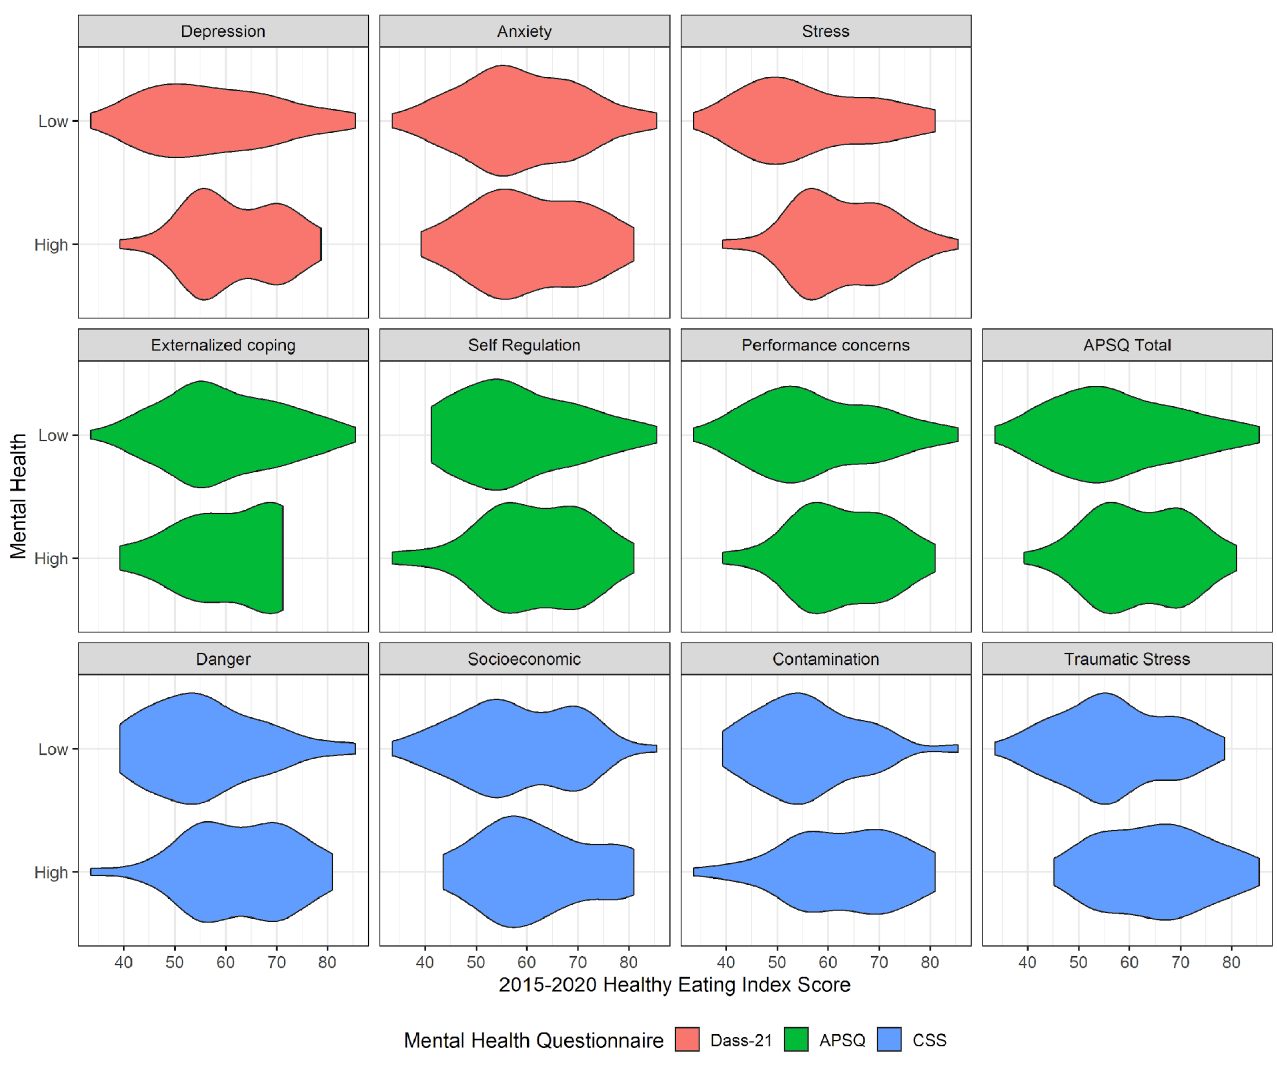
Figure 3. Visual Summary of the distribution of Healthy Eating Index Associations by Participant Mental Health variables.